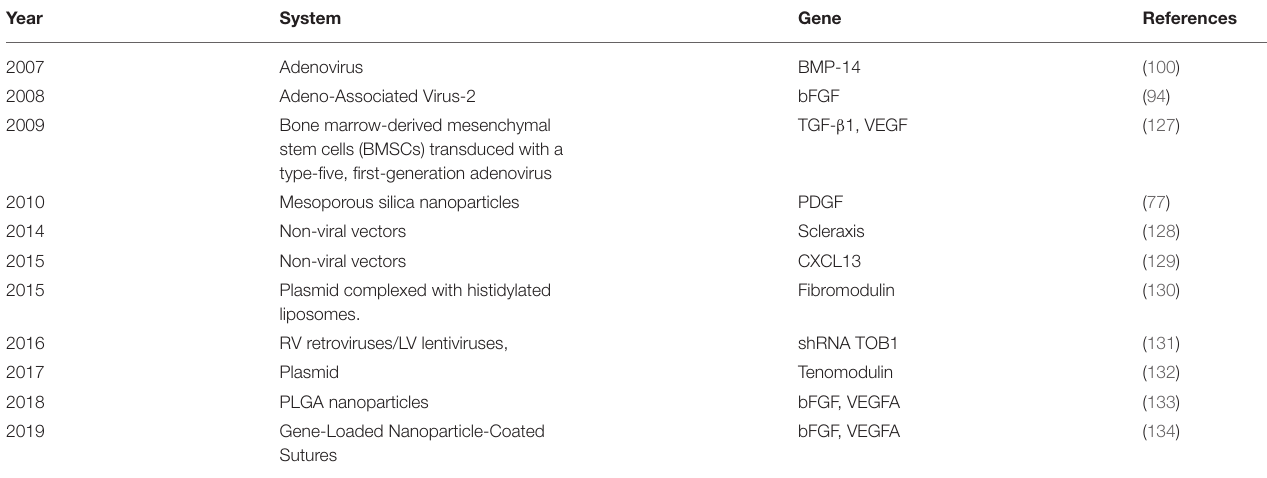
TABLE 1 | Research on gene therapy in recent years.